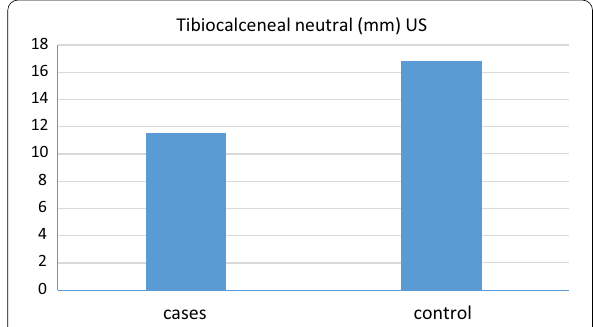
Fig. 2 Correlation of the medial malleolar–navicular distance (MMN) neutral measured by US between patients and controls